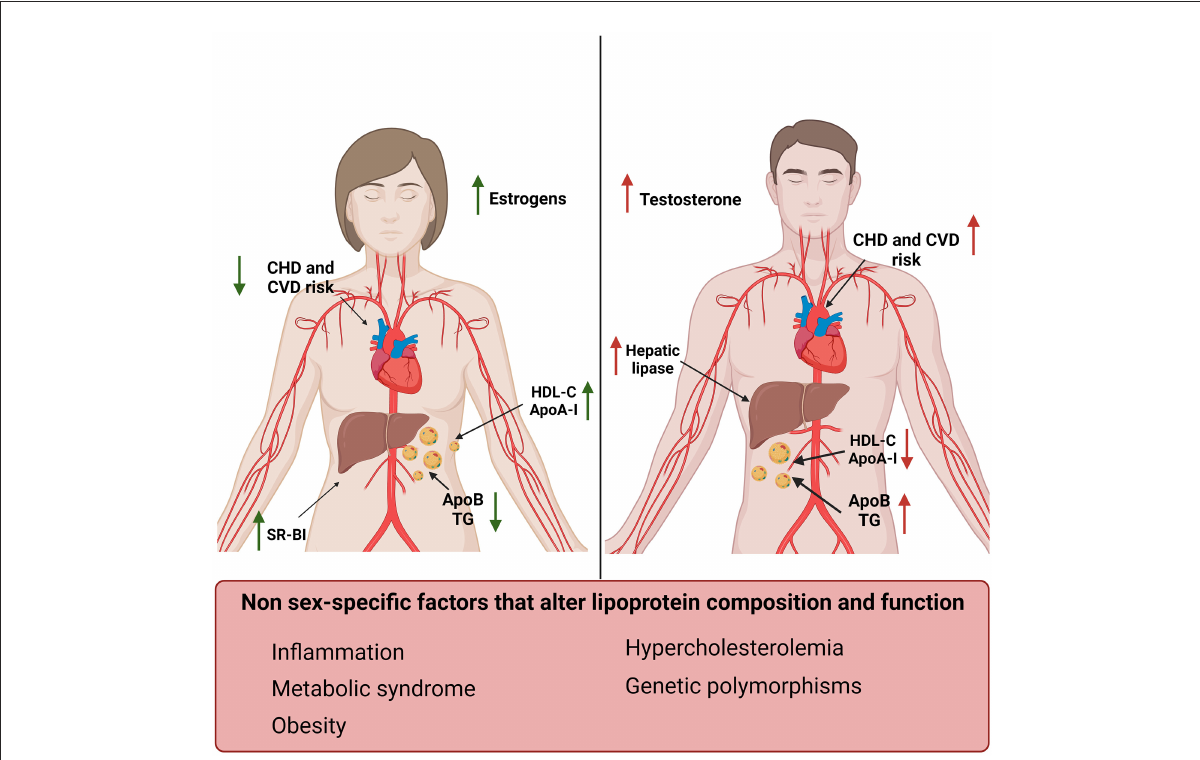
FIGURE1 Sex-specific differences in lipoproteins and their effect on cardiovascular risk factors. Women (left) display increased levels of HDL-C and ApoA-I and reduced levels of TG and ApoB compared to men (right) (12, 49–52). Men also display increased levels of hepatic lipase compared to women, which in turn have higher SR-BI expression levels. These differences correlate with estrogens and testosterone levels and result in a reduced risk for CVD and CHD in women compared to men (53). Sex-independent factors associated with increased risk for CVD and changes in lipid profile have also been reported in this figure (bottom)